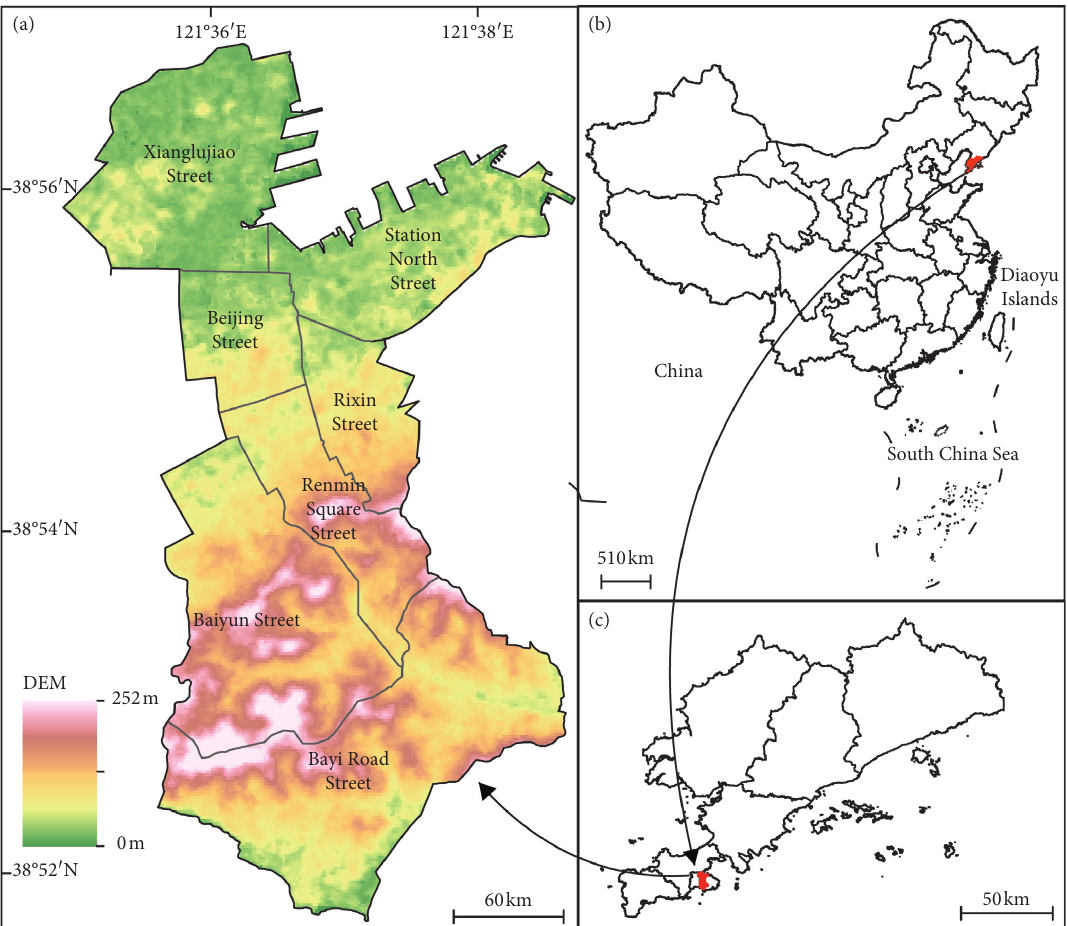
Figure 1: Location of the study area. (a) Digital elevation model (DEM) of the study region; (b) and (c) study area location within China and within Dalian, respectively.